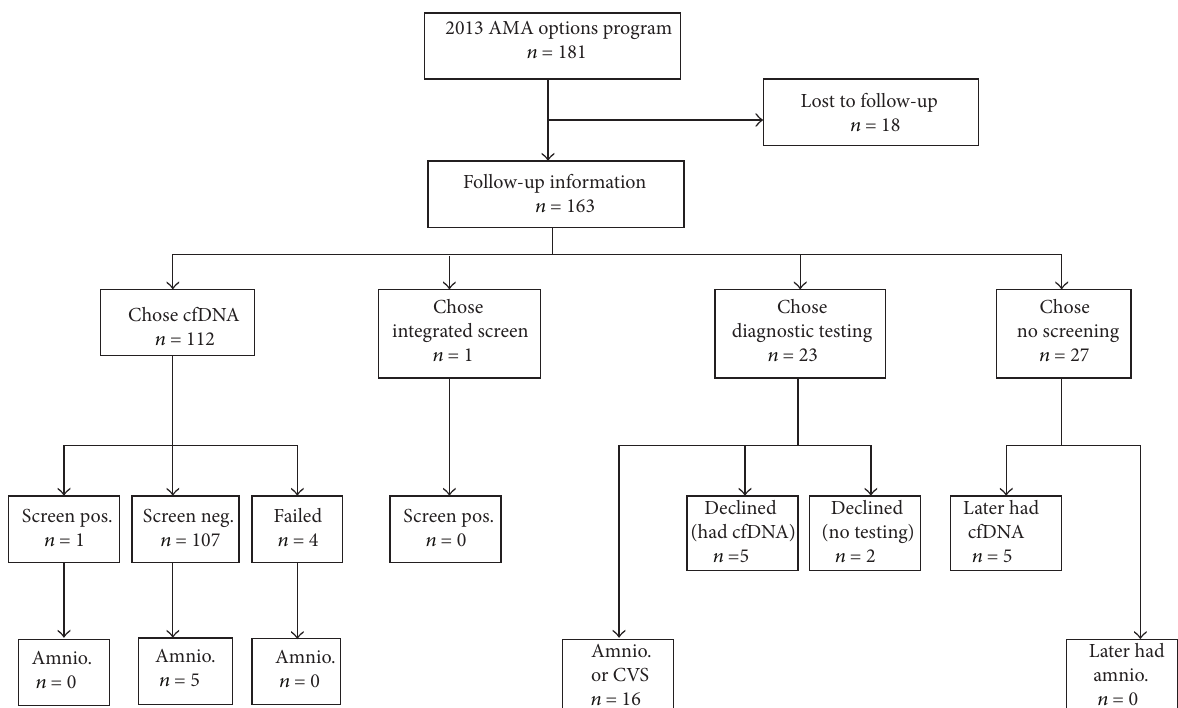
Figure 1: Patient eligibility for AMA Options genetic counseling and choice of testing